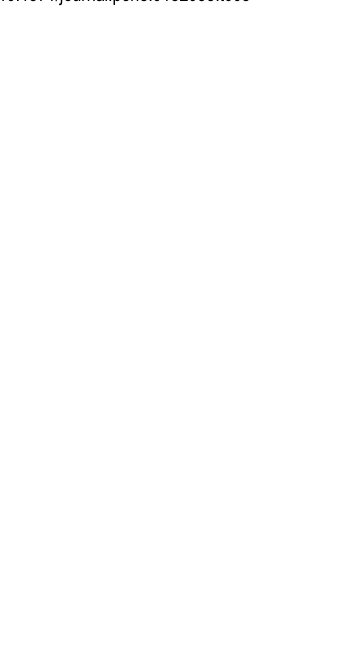
PLOS ONE | DOI:10.1371/journal.pone.0132033 July 6,